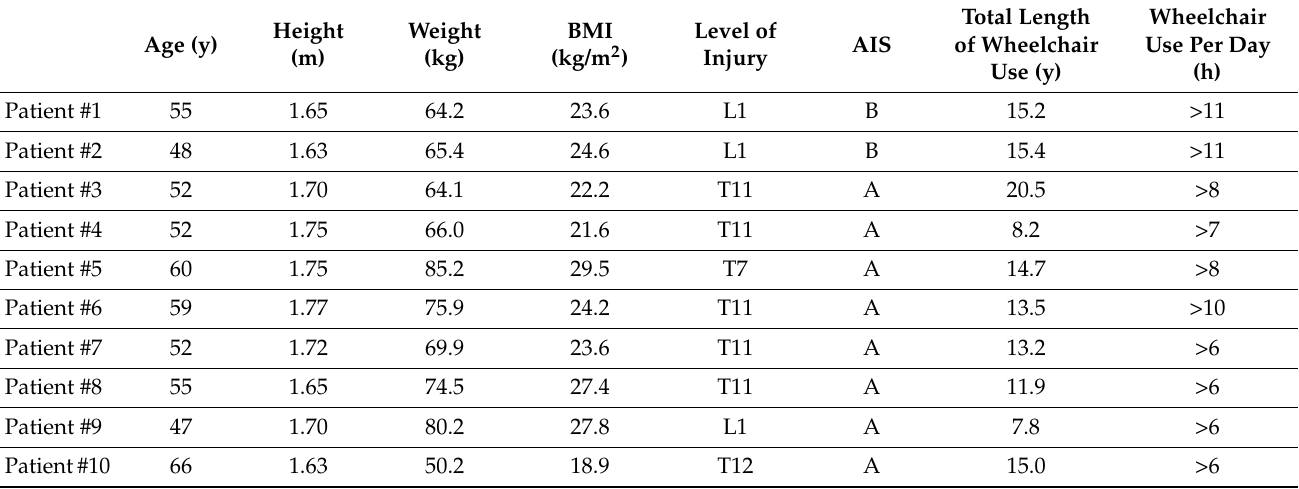
Table 1. Participants’ general characteristics (N =